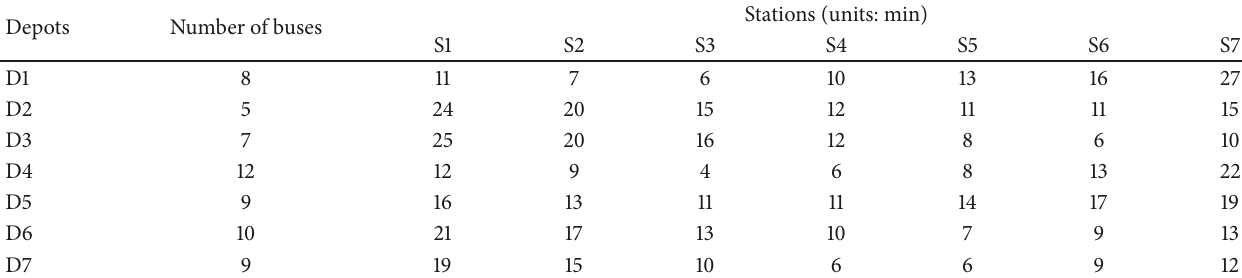
Table 3: Specific data of buses at depots and travel times between depots and stations.